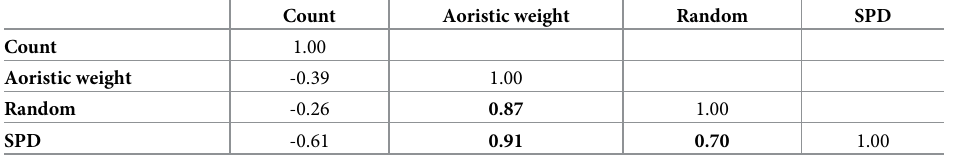
Table 4. Pearson correlation coefficient r-value matrix between the archaeo-demographic proxies (all sites) from 6,000 to 4,000 cal BP. Count